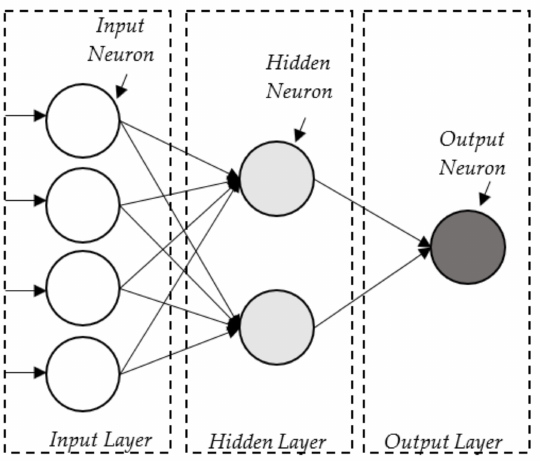
Figure 2. An example of MLP